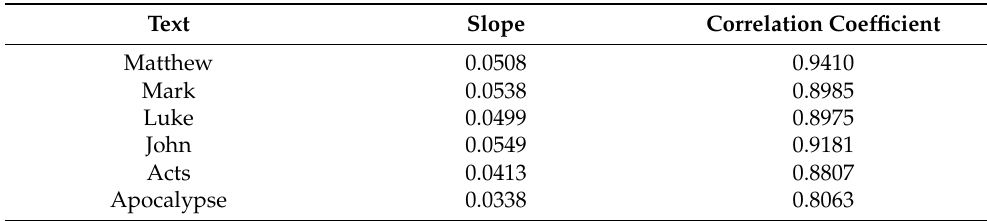
Table 2. Line slope (sentences per word) and correlation coefficient of the regression line between words (independent variable) and sentences (dependent variable) in the indicated New Testament Greek texts. We have reported 4 decimal digits because some values differ only from the third digit. Text Slope Correlation Coefficient Matthew 0.0508 0.9410 Mark 0.0538 0.8985 Luke 0.0499 0.8975 John 0.0549 0.9181 Acts 0.0413 0.8807 Apocalypse 0.0338 0.8063